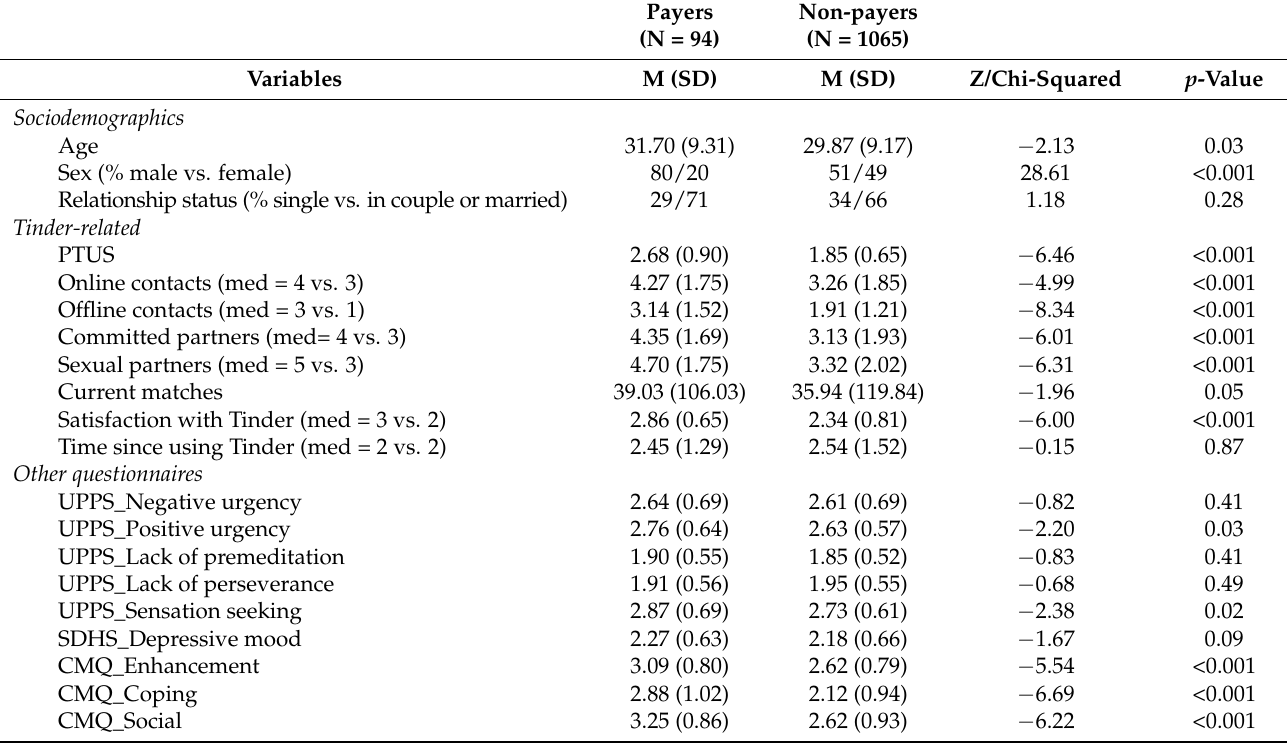
Table 1. Descriptive statistics and group comparisons between Tinder payers vs. non-payers.